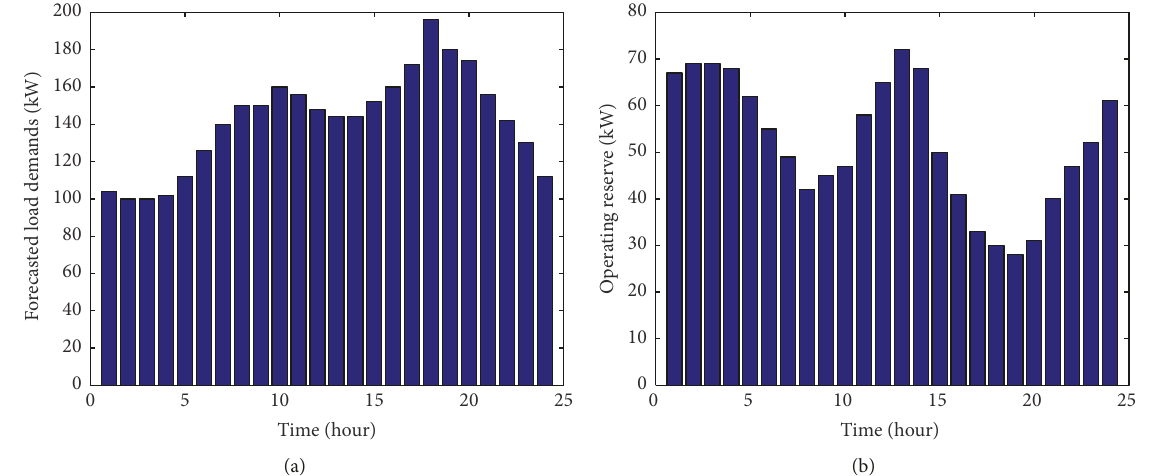
Figure 7: (a) Forecasted load demand and (b) operating reserve